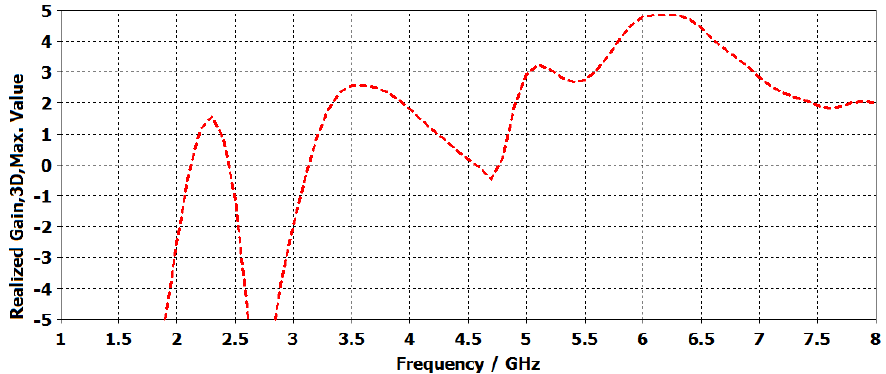
Figure 8: Uniplanar triple band ACS fed antenna peak